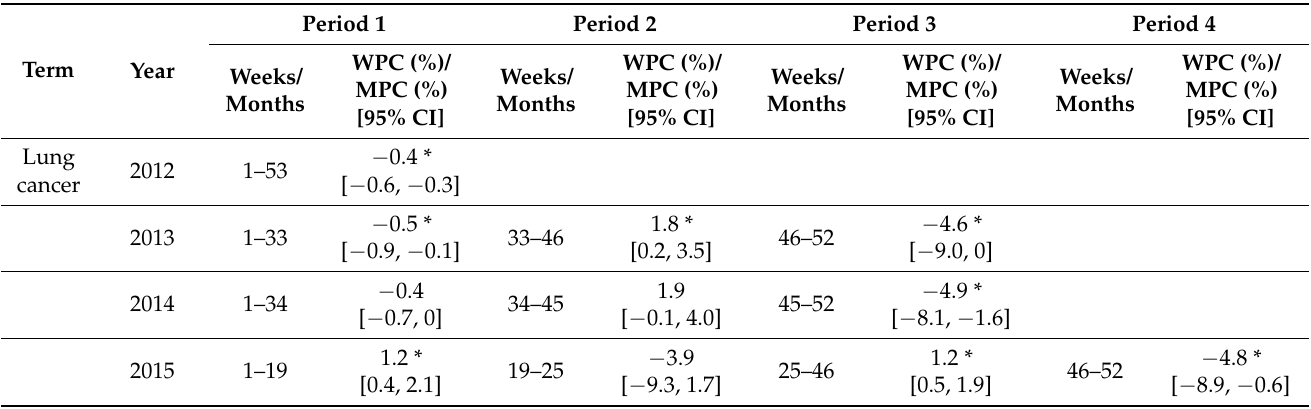
Table 2. Trend changes in relative search volumes of the term “Lung cancer”